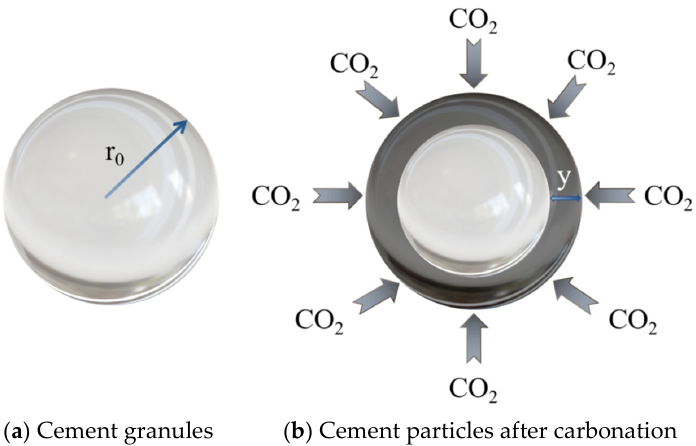
Figure 9. Comparison of cement particles before and after carbonation [85].